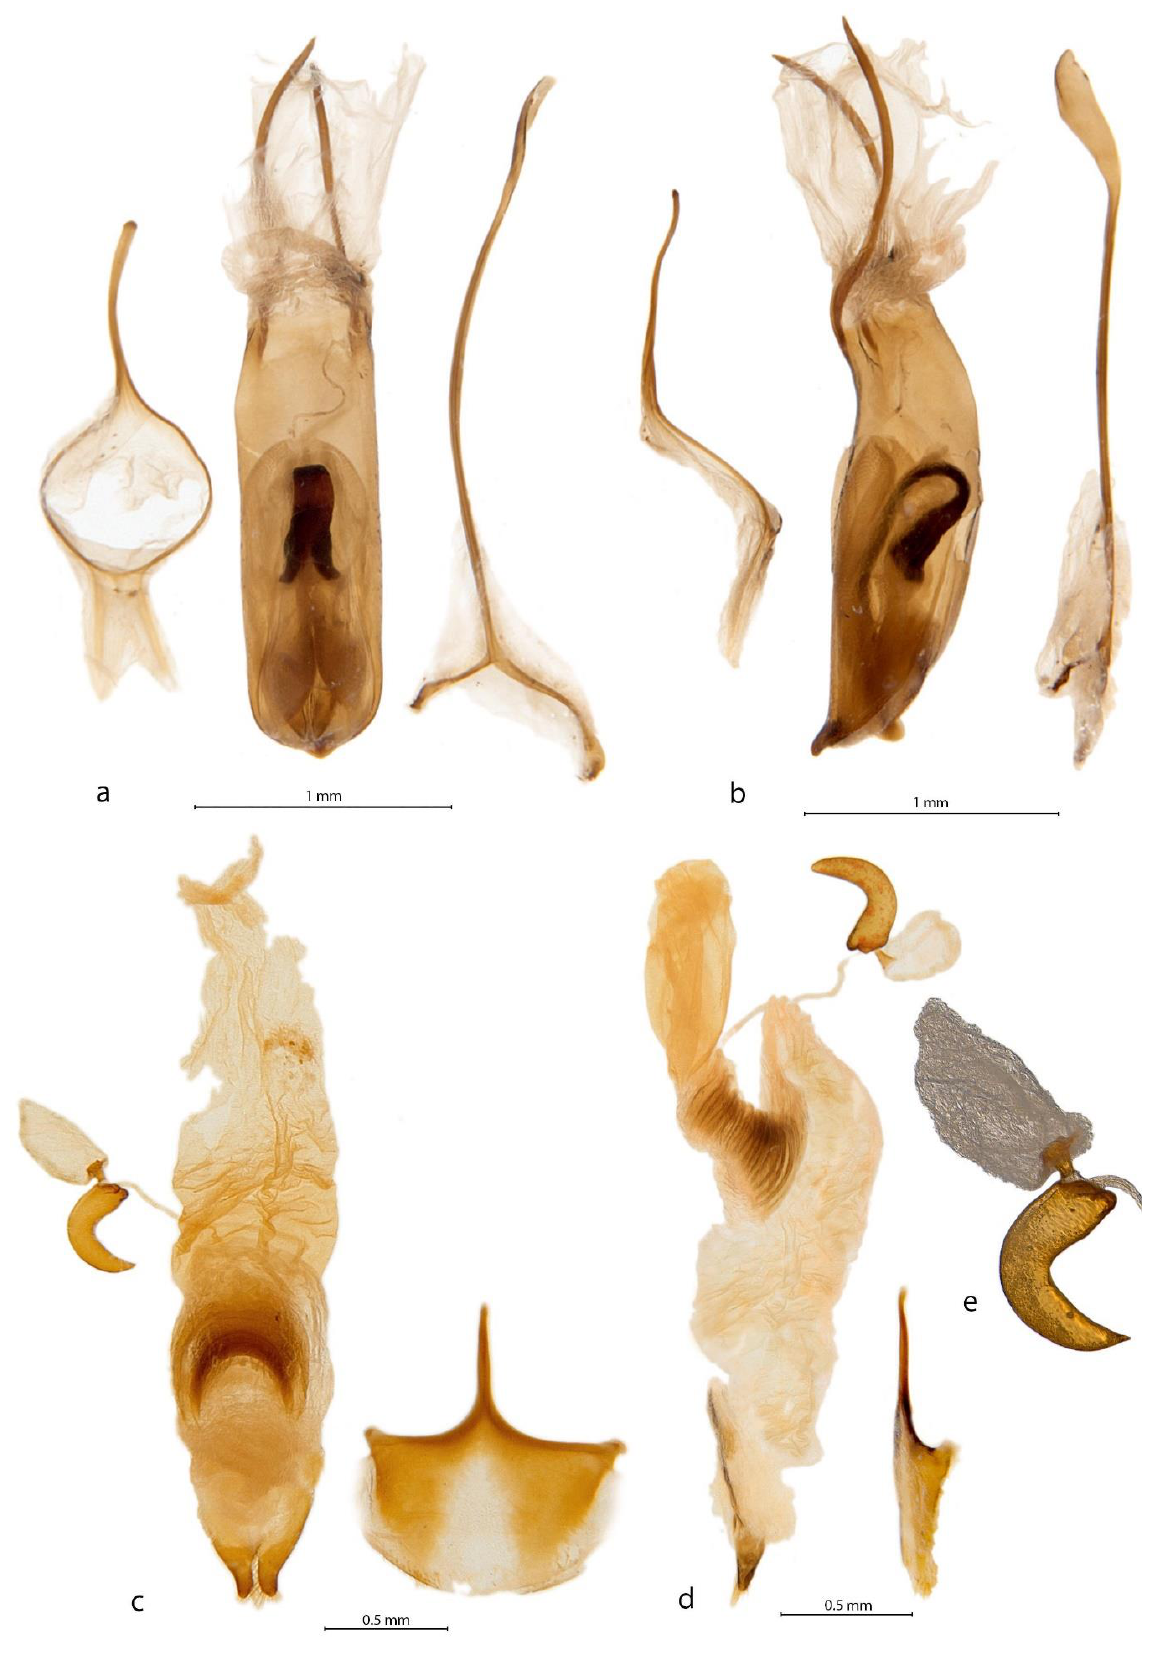
Figure 12. Genitalia of Kuschelorhynchus macadamiae gen. & sp. n.: ( a ) genitalia, male, dorsal view; ( b ) genitalia, male, lateral view; ( c ) genitalia, female, dorsal view; ( d ) genitalia, female, lateral view; ( e ) spermatheca, female.